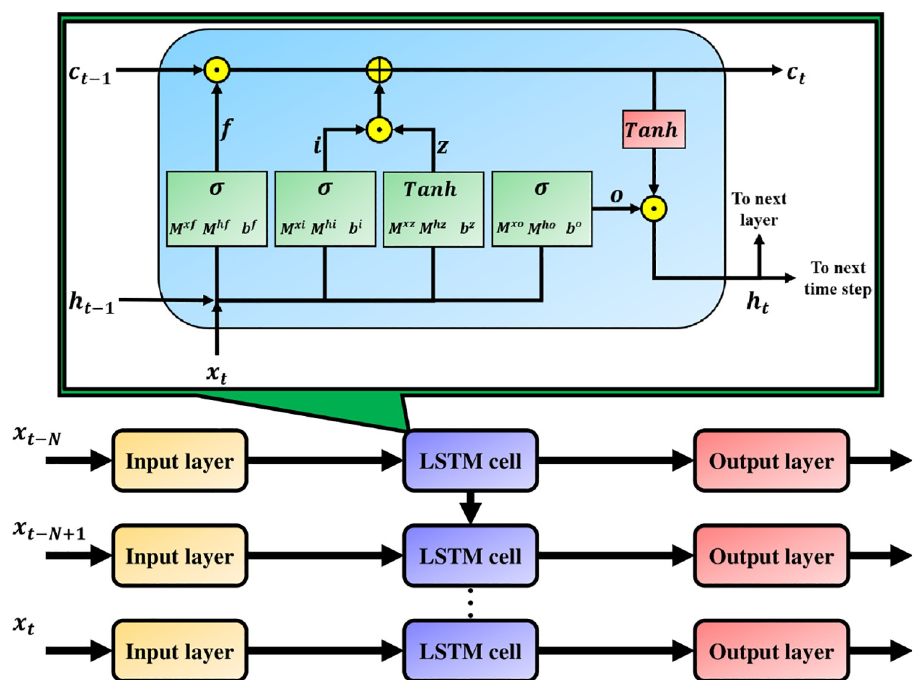
Fig 5. Modern LSTM units and its layer structure are illustrated. Same as those described for Fig 4, there are 10240 feature lengths in the input layer, where he output layer generates 35 predictive targets.